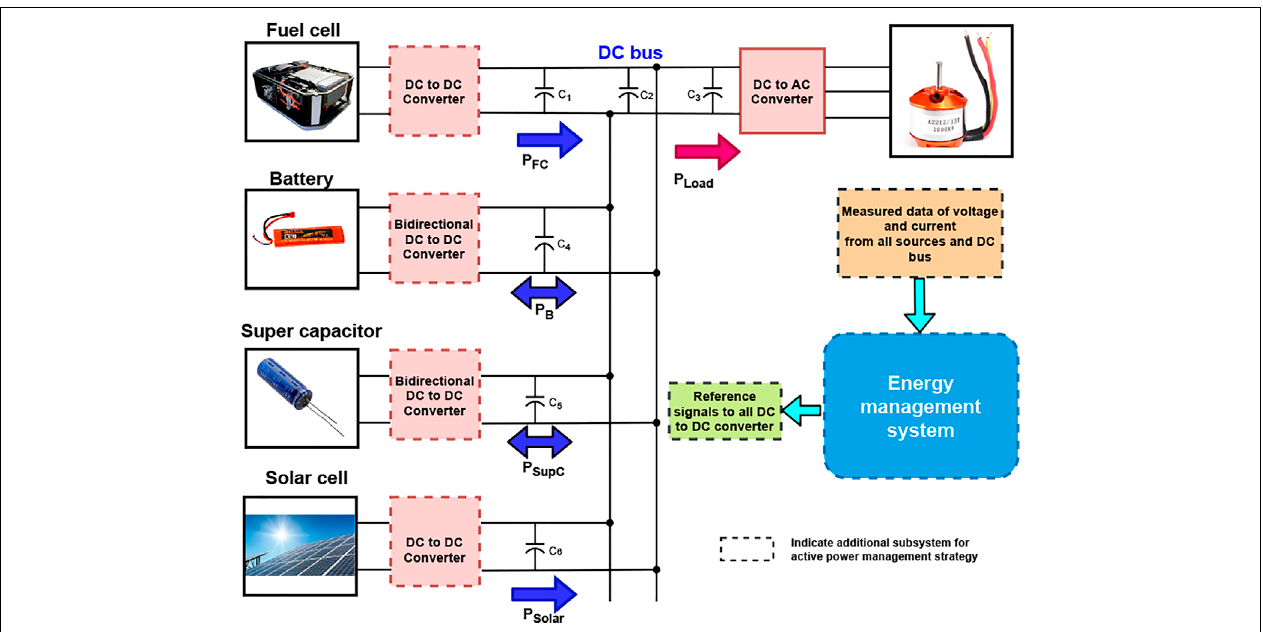
FIGURE 10 | Power management strategy of hybrid propulsion system.